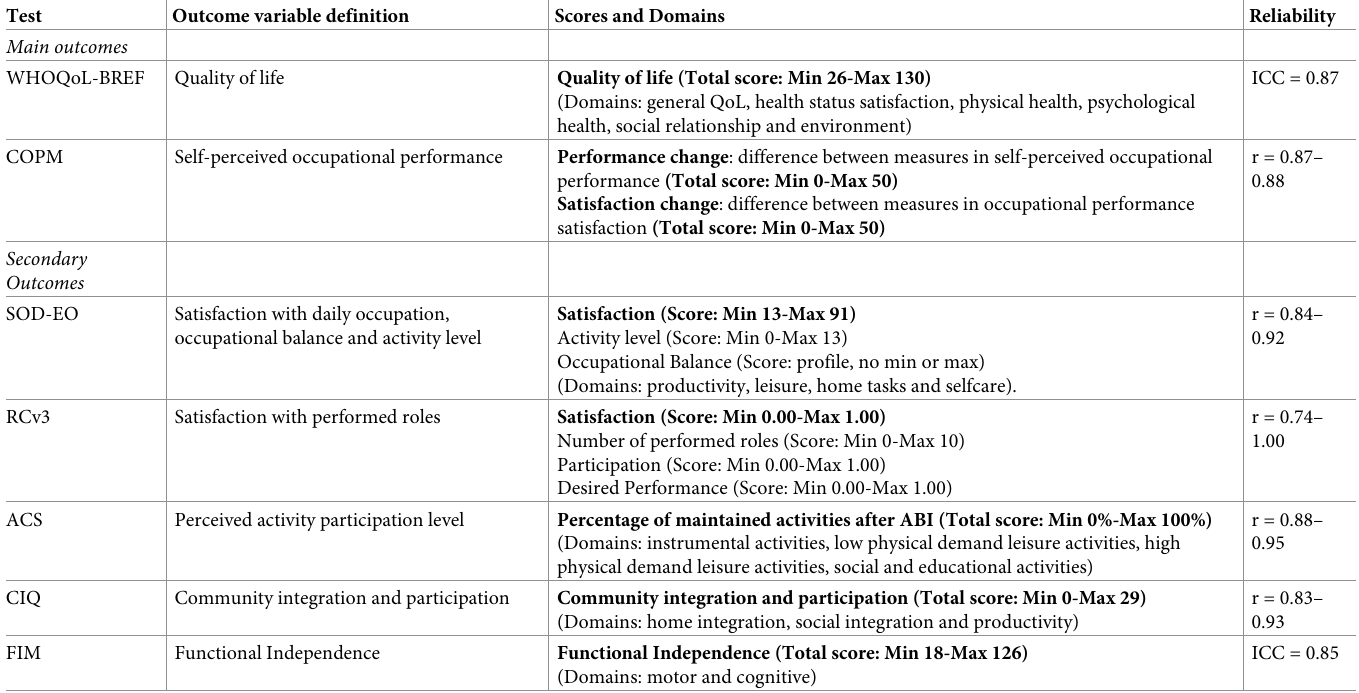
Table 2. Tests and variables used in the data